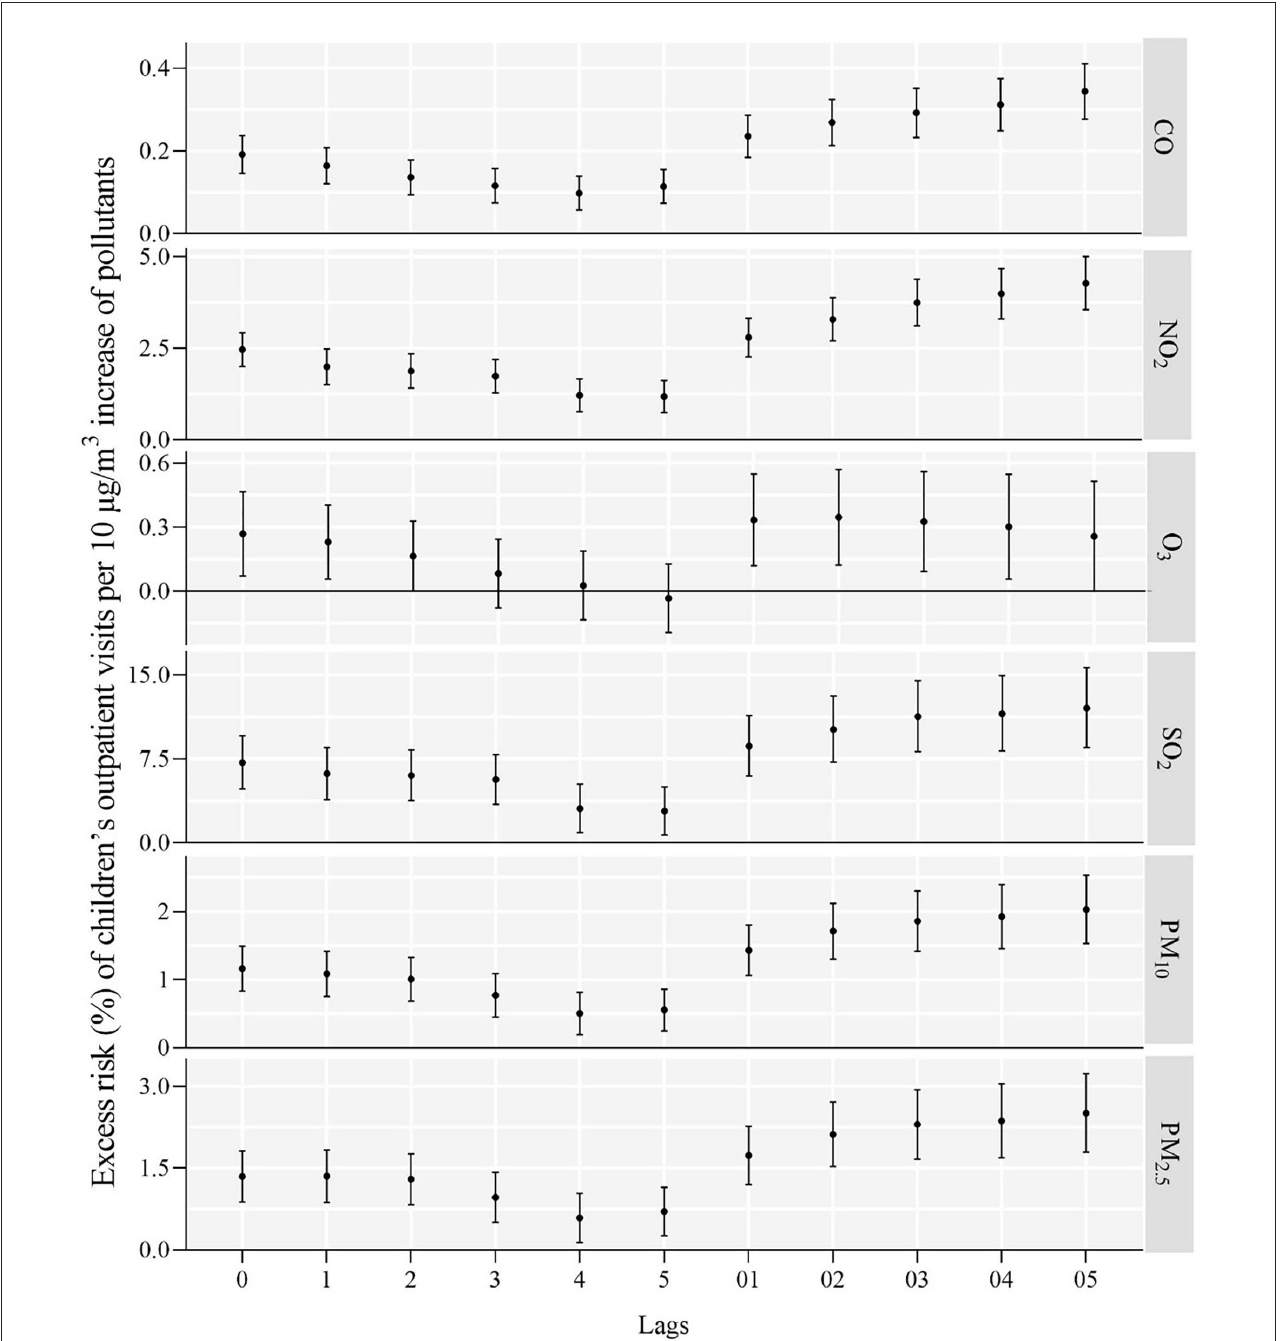
FIGURE1 Excess risk (%) and 95% confidence intervals of children’s outpatient visits a 10 µ g/m 3 increase in various ambient air pollutant concentrations along different lag